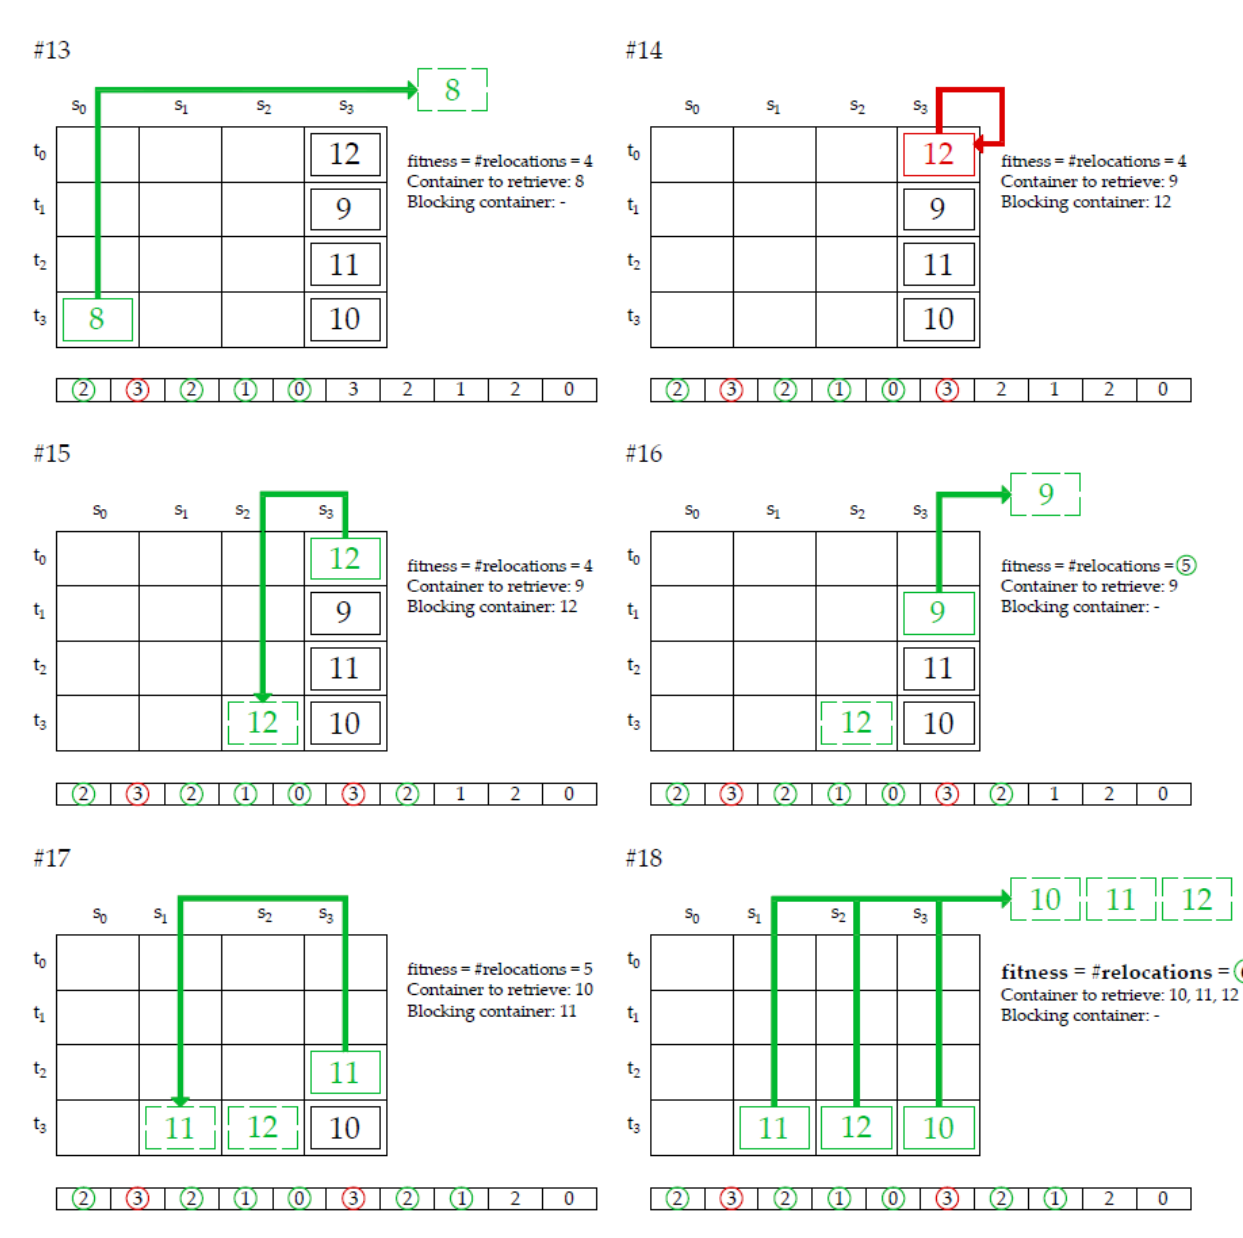
Figure 9. A complete fitness function calculation (3).